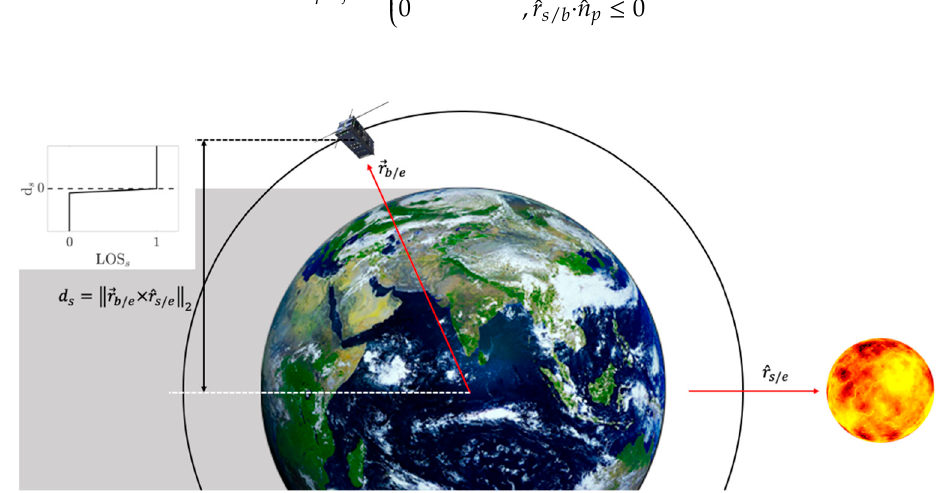
Figure 6. Illustration of Sun line-of-sight.